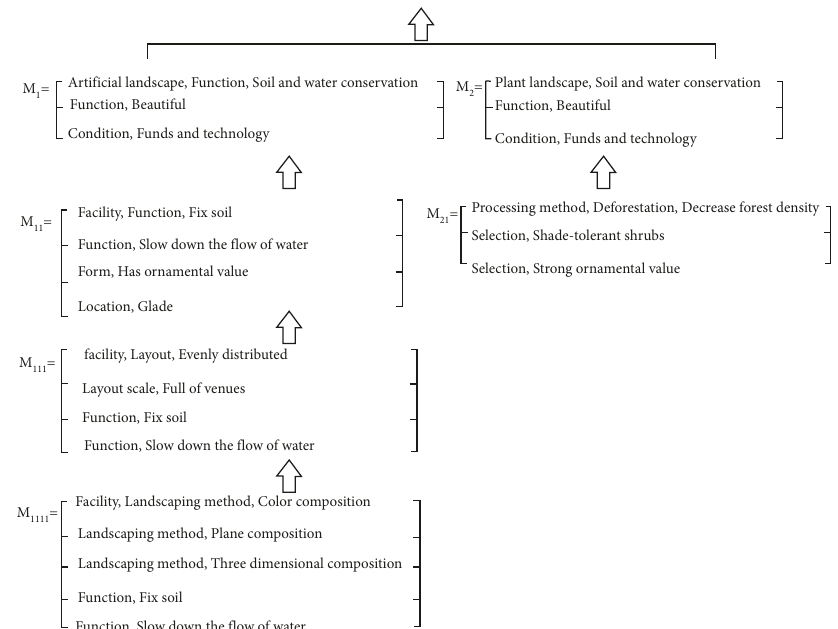
Figure 6: Implication analysis.